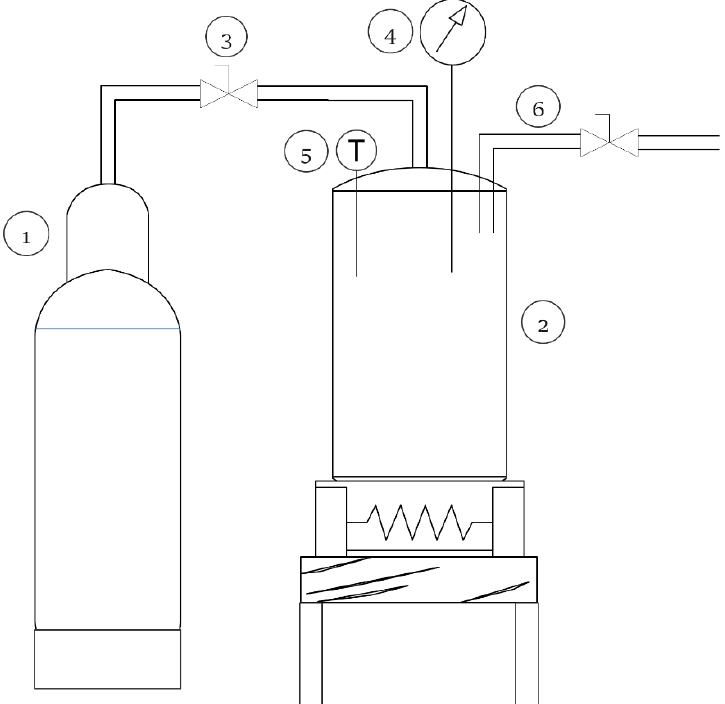
Figure 7. Supercritical carbon dioxide reactor scheme: 1: CO 2 cylinder, 2: high pressure reactor, 3: valve, 4: pressure indicator, 5: temperature indicator, and 6: CO 2 release.